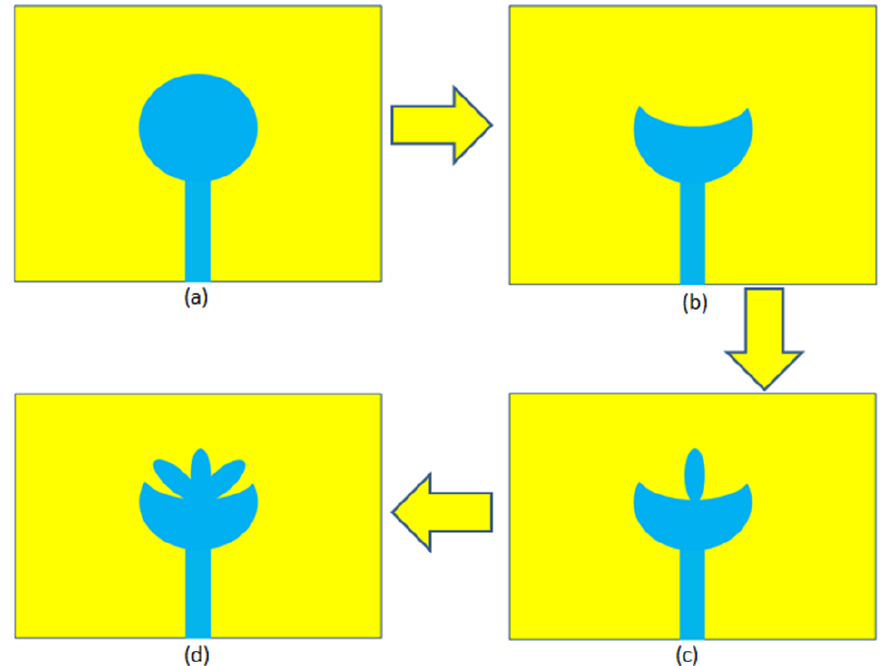
Figure 2. The development process of dual-band THz antenna: ( a ) Step 1; ( b ) Step 2; ( c ) Step 3; and ( d ) Step